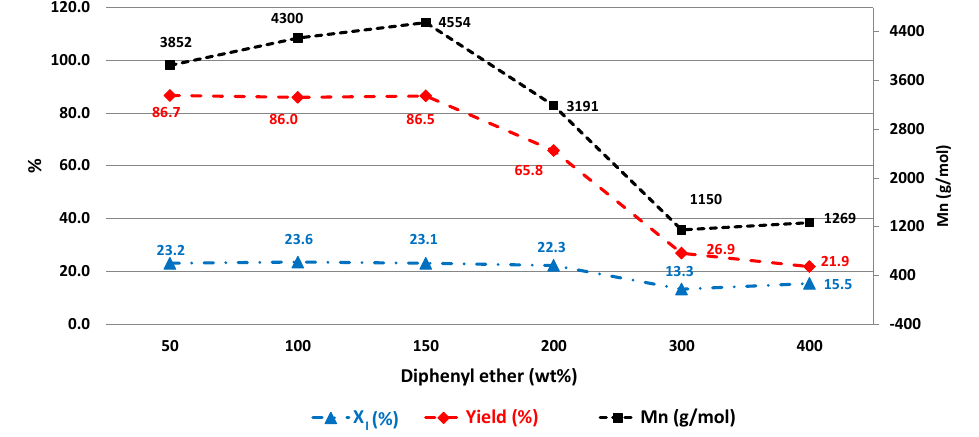
Figure 2. The effect of diphenyl ether dosage on CALB-catalyzed synthesis of